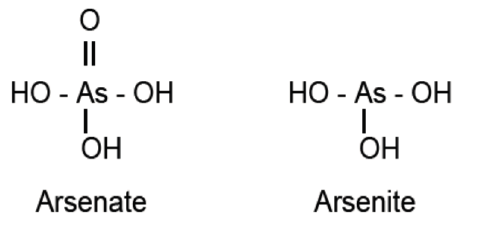
Figure 2. Inorganic forms of